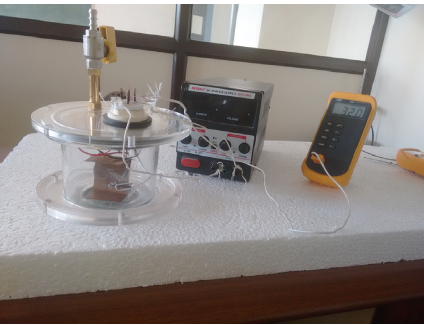
Figure 3: Experimental setup for calculation of thermoelectric